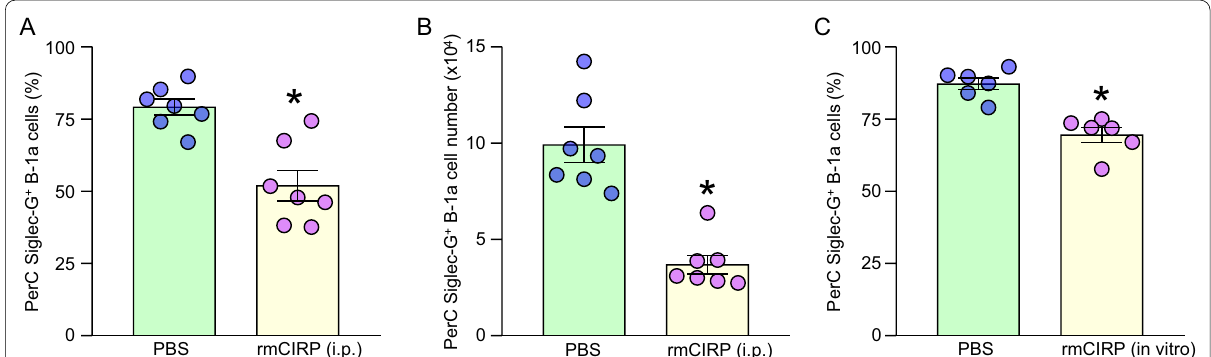
Fig. 4 rmCIRP induces a downregulation of Siglec-G expression by B-1a cells in vivo and in vitro. 20 h after i.p. injection of rmCIRP, PerC lavage samples were collected. Peritoneal cells were stained with CD23, B220, CD5, and Siglec-G Abs and subjected to flow cytometric detection of B-1a cells and analysis of Siglec-G expression. Status of Siglec-G expression by B-1a cells in terms of A frequency and B number after i.p. injection of rmCIRP are shown. PerC B-1a cells were stimulated with rmCIRP in vitro for 24 h. Cells were stained with Siglec-G Ab and subjected to flow cytometric analysis. C Frequency of Siglec-G expression on B-1a cells after stimulation with rmCIRP are shown. Data are expressed as means (n 6–7 mice/group). The groups were compared by Student’s t-test (*p < 0.05 vs. vehicle treatment) =